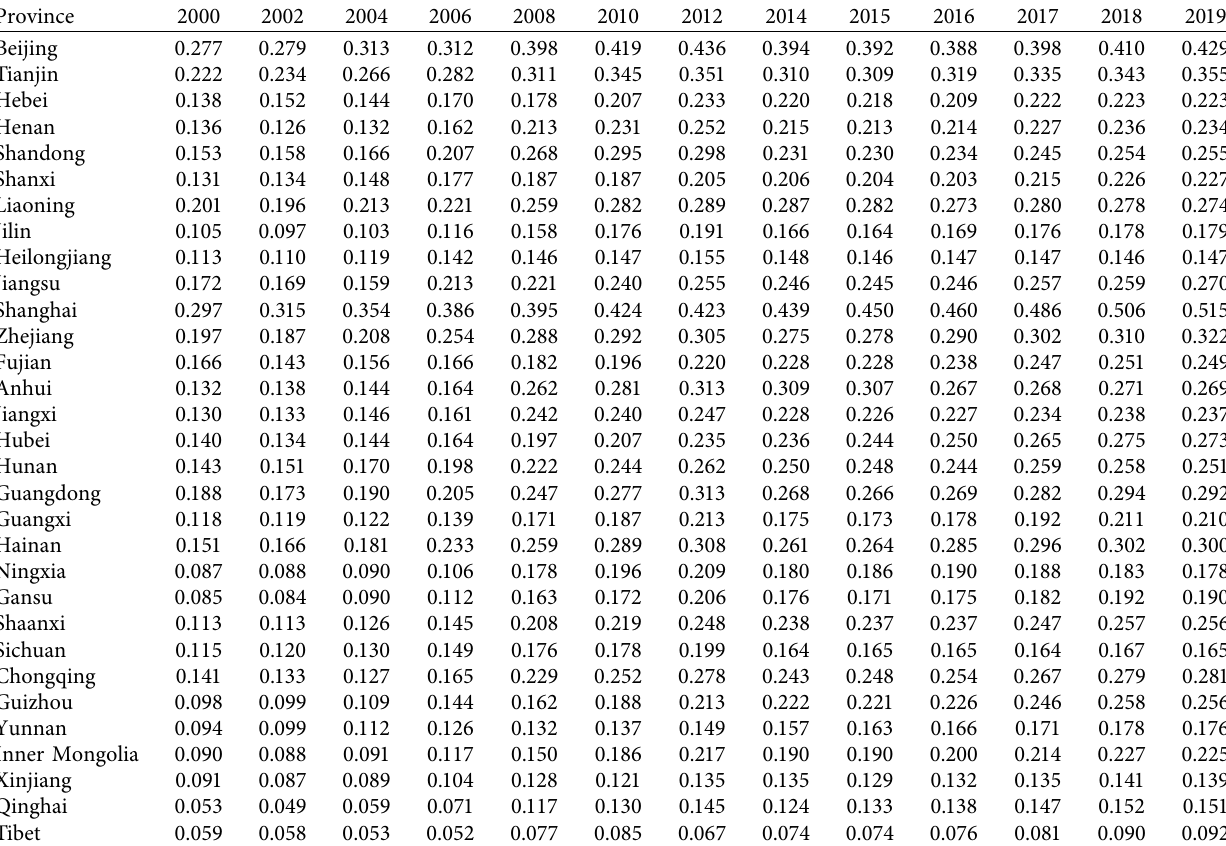
Table 4: Te level of quality development in integrated transport varies by province.